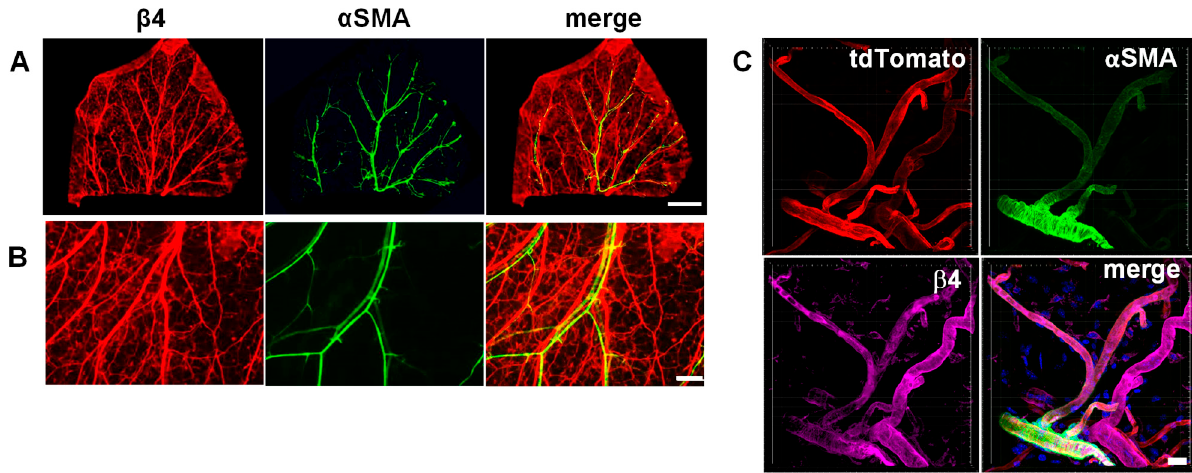
Figure 1. The α 6 β 4 integrin is expressed in veins and venules of the dermal vasculature: ( A ) immunofluorescence staining of whole-mount mouse ear for α -SMA and β 4-integrin subunit. Scale bar = 2 mm; ( B ) image of β 4 and α -SMA expression acquired at a higher magnification. Scale bar = 500 µm; ( C ) confocal immunofluorescence staining of mouse skin for α -smooth-muscle actin and β 4-integrin subunit. Vasculature is identified by tdTomato (red) expression. Image is a maximum projection of acquired z-stack. Arrowhead indicates the location of an arteriole. Scale bar = 20 µm.